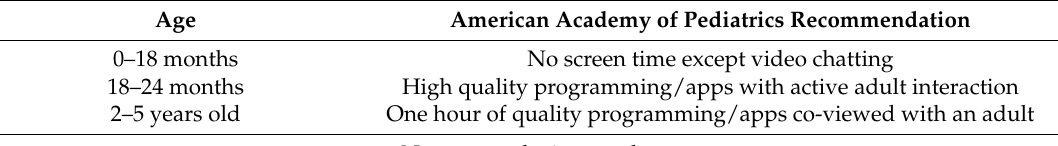
Table 1. Current daily screen time recommendations 0–5 years